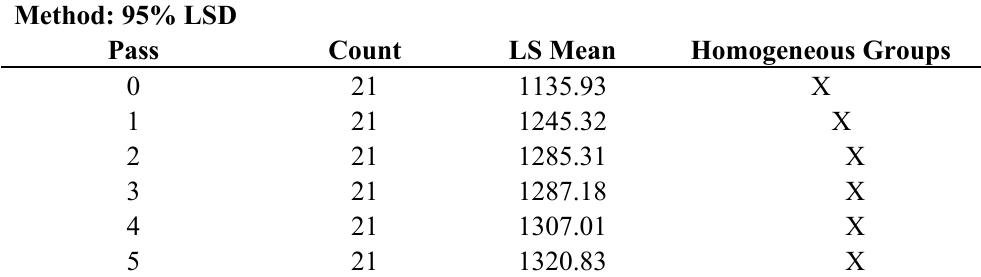
Table 3. Multiple Range Test for dry bulk density at the surface by pass of tractor.